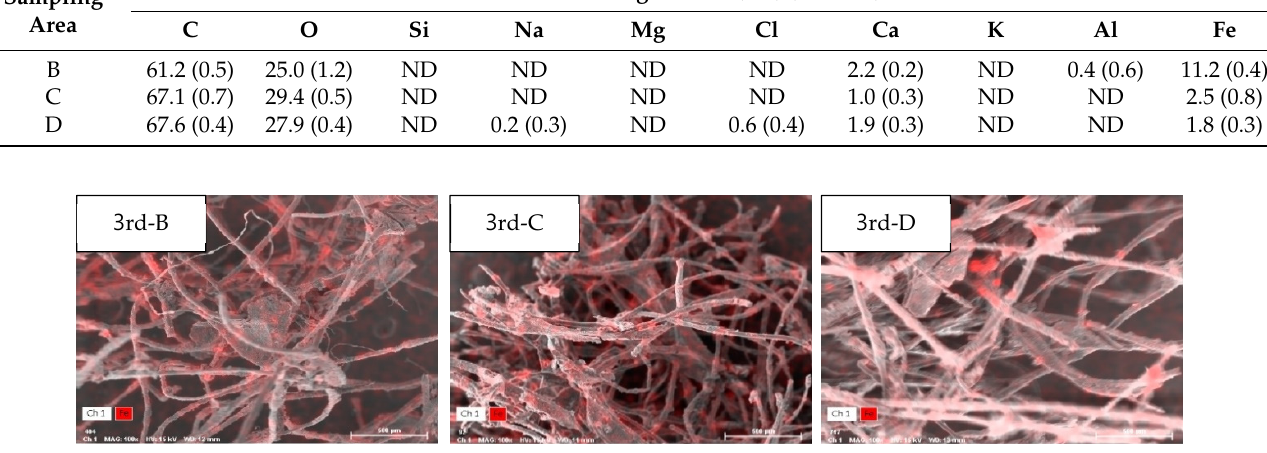
Figure 4. Element analysis of the return air, using SEM-EDS, on June 28. In the RA sample collected in the third cycle (1 August), the weight ratio of Fe increased (Table 7 and Figure 5), and the upper part of RA (B) recorded the highest weight ratio (11.2 wt.%) among all cycles. The weight ratio recorded in the upper part (B) was 4.5 to 6.2 times higher than that recorded in the middle and lower parts (C and D, respectively). Table 7. Element analysis of the return air, using SEM-EDS, on 1 August. Mean Weight Ratio (SD) (in wt.%)